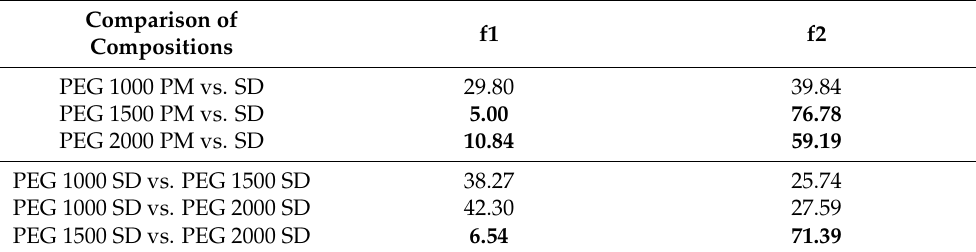
Figure 6. Dissolution profiles of solid dispersions and physical mixtures in hydrochloric acid media. Data are represented as the average ( ± SD) detected amount of ketoprofen compared to the average amount of ketoprofen loaded into the capsules, n = 3. The dotted line represents the theoretical maximum solubility of ketoprofen in the presence of the PEGs based on the phase solubility study (90 mg of PEG in 450 mL of hydrochloric acid media, average is calculated and plotted from the result of the three polymers). Table 4. Difference and similarity factors of the dissolution profiles of the samples.